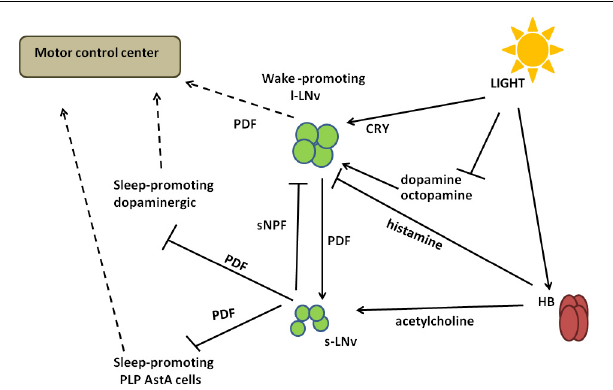
FIGURE 5 | A schematized circuit of circadian regulation of sleep. Light signals received by Hofbauer–Buchner eyelets (HB) are transmitted through acetylcholine to small ventral-lateral neurons (s-LNvs) and through histamine to large ventral-lateral neurons (l-LNvs). Activated s-LNvs release pigment dispersing factor (PDF), which inhibits dopaminergic and AstA-expressing sleep-promoting cells. The regulation of l-LNvs activity is more complex, as they express light-sensitive Cryptochrome (CRY) as well as dopamine and octopamine receptors. Light activates CRY, but at the same time it inhibits the response to dopamine and octopamine, decreasing signal inputs to l-LNvs. In addition, l-LNvs receive inhibiting inputs from s-LNvs through short Neuropeptide F (sNPF). Different signalling inputs are processed in l-LNvs and transmitted to the motor control center through